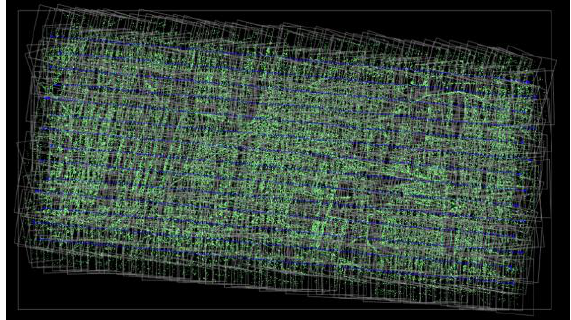
Figure 4. Image block with automatic tie points - UASMaster